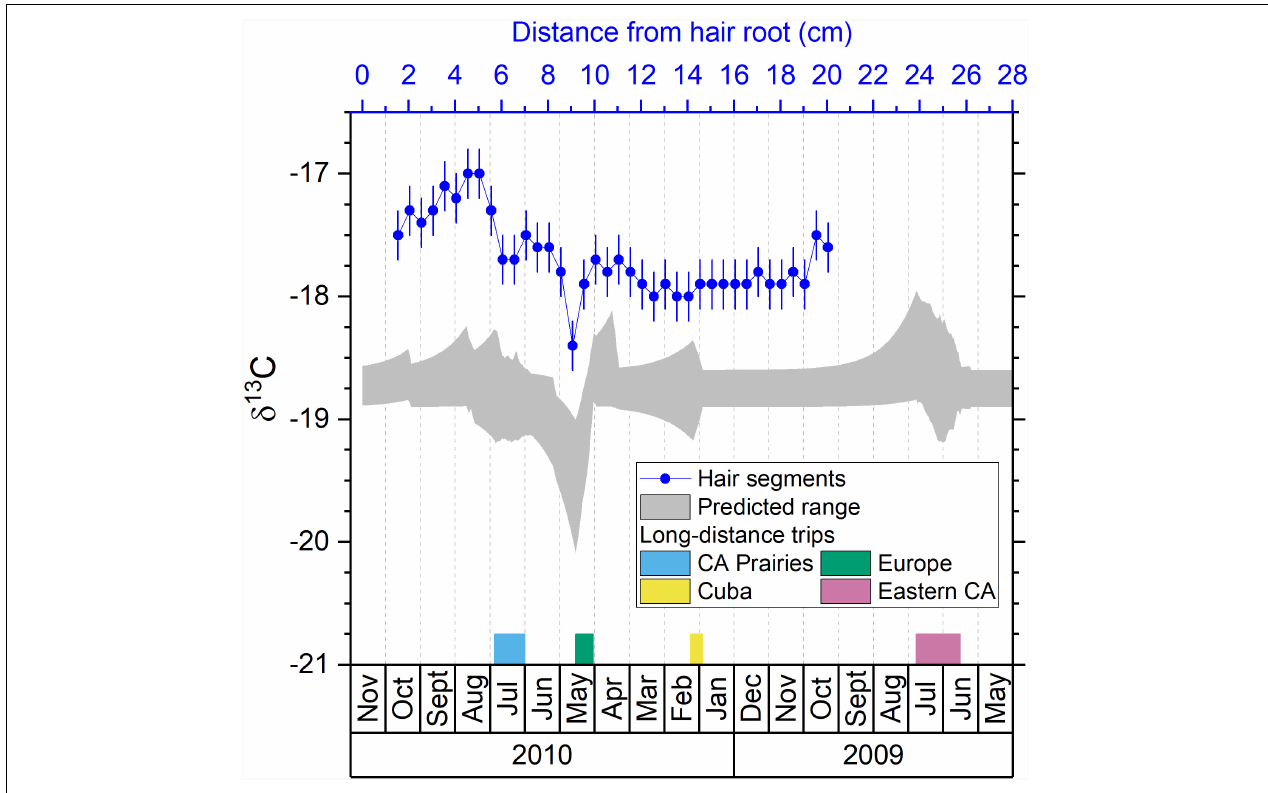
FIGURE 3 | Comparison between the predicted isotopic profile and the measured isotopic values in hair segments for carbon. Blue dots are the measured δ 13 C values in hair segments versus their distances from the hair root (top axis) . The shaded area is the predicted range of δ 13 C values in hair versus the date (bottom axis) . The periods of the four major trips are marked with colored bars next to the bottom axis.